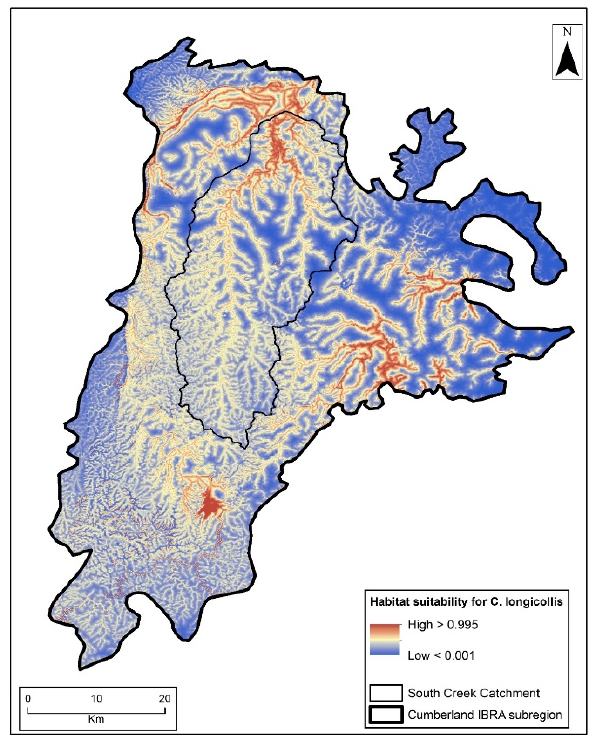
Figure 11. Predicted habitat suitability for the eastern snake-necked turtle ( Chelodina longicollis ) in the Cumberland Interim Biogeographic Regionalisation of Australia (IBRA) subregion.